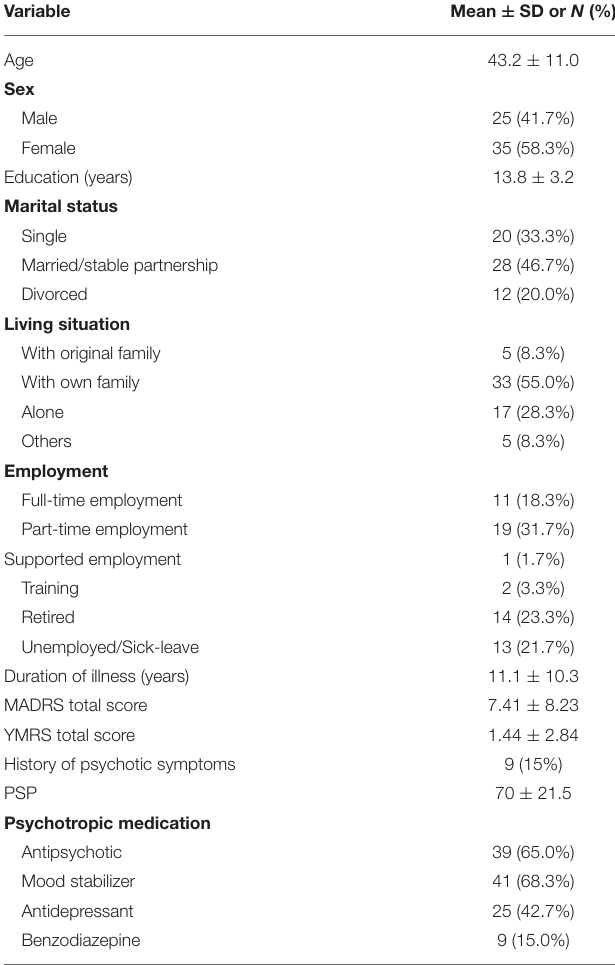
TABLE 1 | Patient characteristics ( N = 60 bipolar patients). Variable